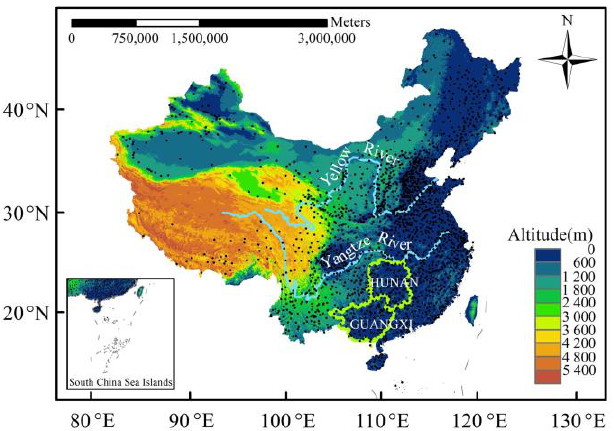
Figure 1. The illustration of the research area and the location of weather stations (black dots).